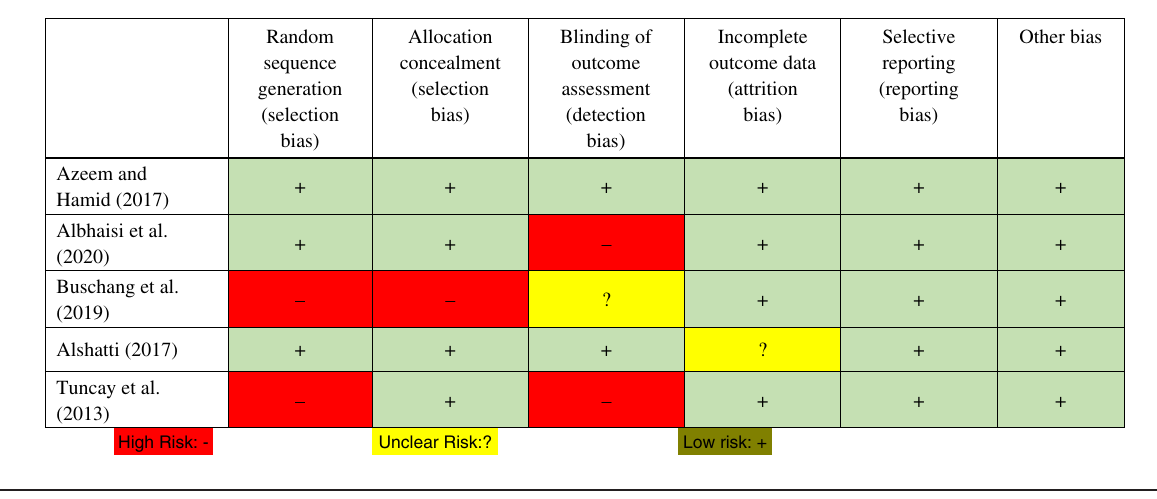
Table V. Risk of bias